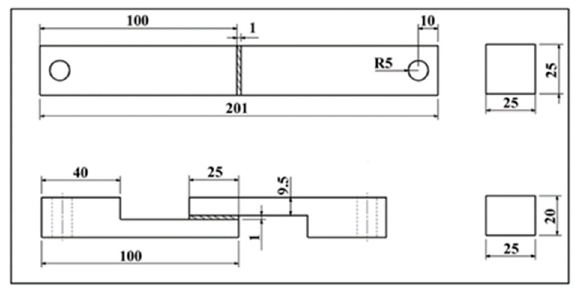
Figure 2. Schematic diagram of docking and lap joints (mm).